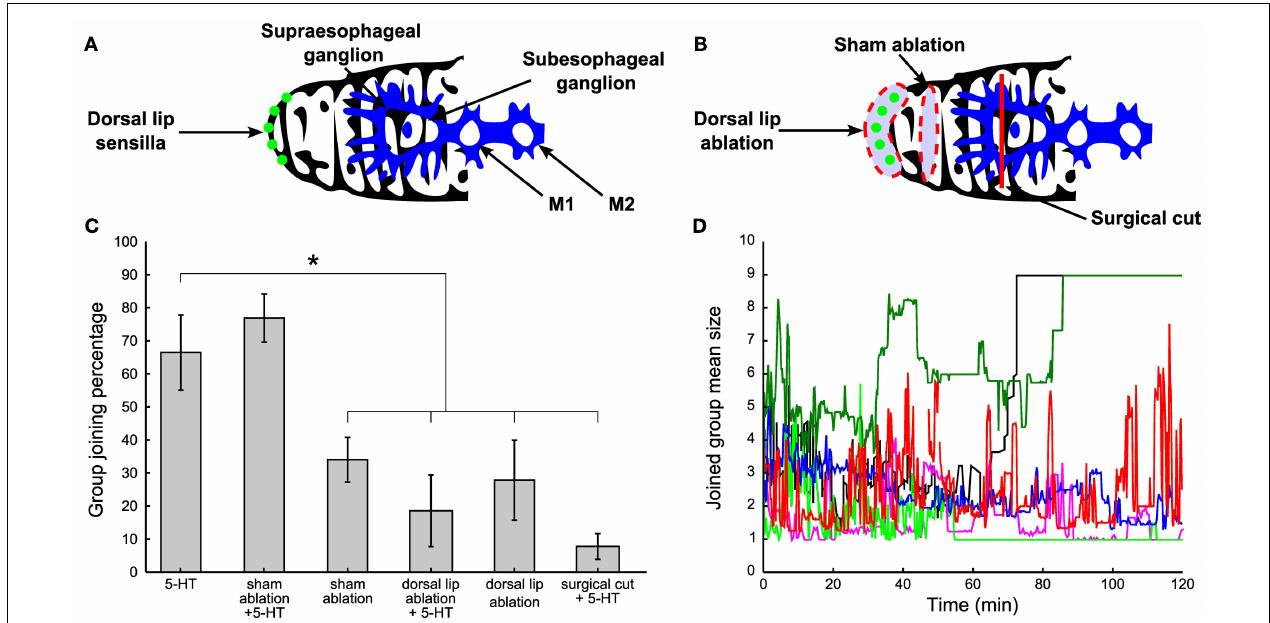
(C) Percentage of time spent by leeches under the above explained surgical treatments in comparison with normal 5-HT injected leeches.Three-hundred microliter of 200 μ M 5-HT were injected in both ablated and supraesophageal ganglion impaired leeches. (D) Time evolution of the mean size of the group joined by the injected leech under the same treatments described in (A,B) . Blue trajectories refer to 5-HT injected leeches and sham-ablated, 5-HT injected leeches respectively, red trajectories refer to sham-ablated leeches, dorsal lip ablated leeches, while light green trajectories refer to dorsal lip ablated and supraesophageal ganglion impaired leeches, all injected with μ l of 200 μ M 5-HT. Student’s t -test, * p <